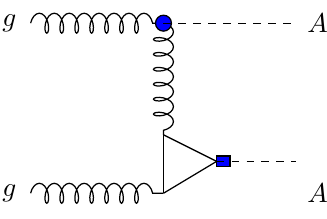
Figure 3 . Type-IIb Diagram involving mixing of the e(cid:11)ective vertices Agg and Aq (cid:22) q (denoted by shaded rectangle) which contribute at O ( a 4 s